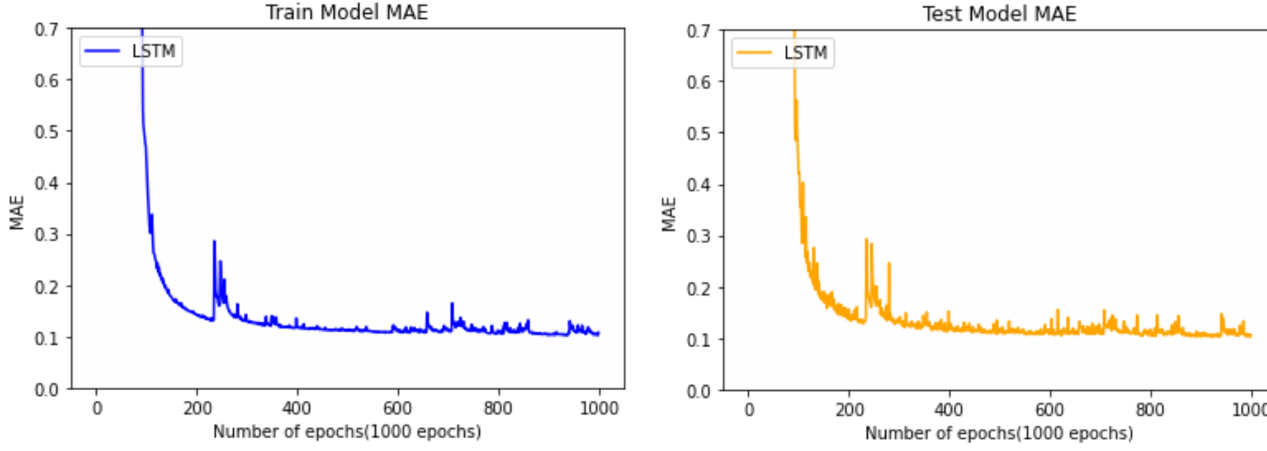
Figure 12. Comparison between train data and test data of the model using the LSTM